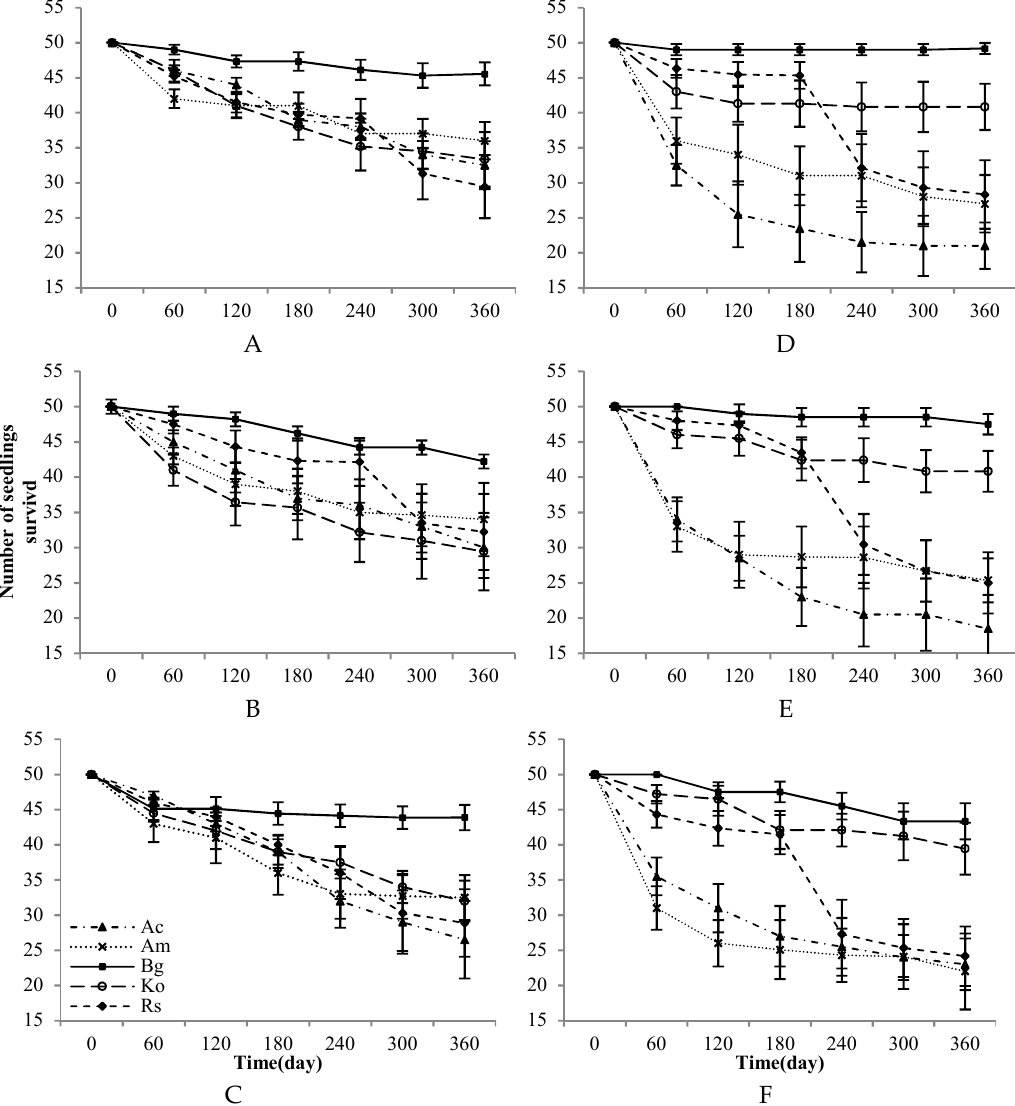
Figure 2. The number of seedlings of the five mangrove species surviving (Bg = Bruguiera gymnorrhiza , Figure. 2. The number of seedlings of the five mangrove species surviving ( Bg = Bruguiera Ac = Aegiceras corniculatum , Ko = Kandelia obovata , Rs = Rhizophora stylosa , Am = Avicennia marina ) gymnorrhiza , Ac = Aegiceras corniculatum , Ko = Kandelia obovata, Rs = Rhizophora stylosa, Am = ( A ) 30% canopy closure and high intertidal elevation, ( B ) 60% canopy closure and high intertidal Avicennia marina ) ( A ) 30% canopy closure and high intertidal elevation, ( B ) 60% canopy elevation ( C ) 90% canopy closure and high intertidal elevation, ( D ) 30% canopy closure and low closure and high intertidal elevation ( C ) 90% canopy closure and high intertidal elevation, ( D ) intertidal elevation, ( E ) 60% canopy closure and low intertidal elevation, ( F ) 90% canopy closure and 30% canopy closure and low intertidal elevation, ( E ) 60% canopy closure and low intertidal low intertidal elevation, ( F ) 90% canopy closure and low intertidal elevation.